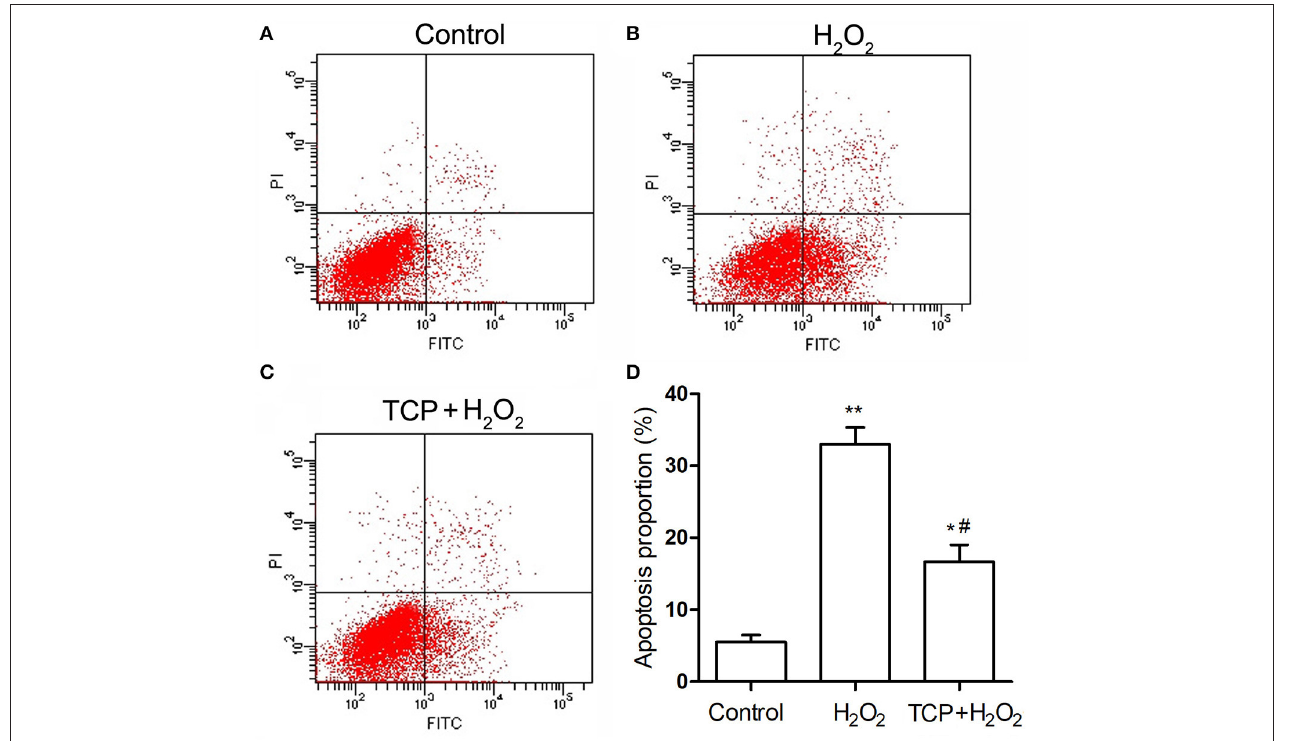
FIGURE 5 | Apoptosis of TCP-protected HUVECs against H 2 O 2 -induced injury. (A) Control group. (B) H 2 O 2 group. (C) 10 µ g/mL TCP + 50 µ M H 2 O 2 group. (D) Apoptosis proportion of TCP-protected HUVECs against H 2 O 2 -induced injury. The data are expressed as the means ± SD. Statistically significant differences among different groups: * P < 0.05, ** P < 0.01, compared to the control group; # P < 0.05, compared to the H 2 O 2 group. TCPs in tuna head soup at the boiling time of 150min were applied in this